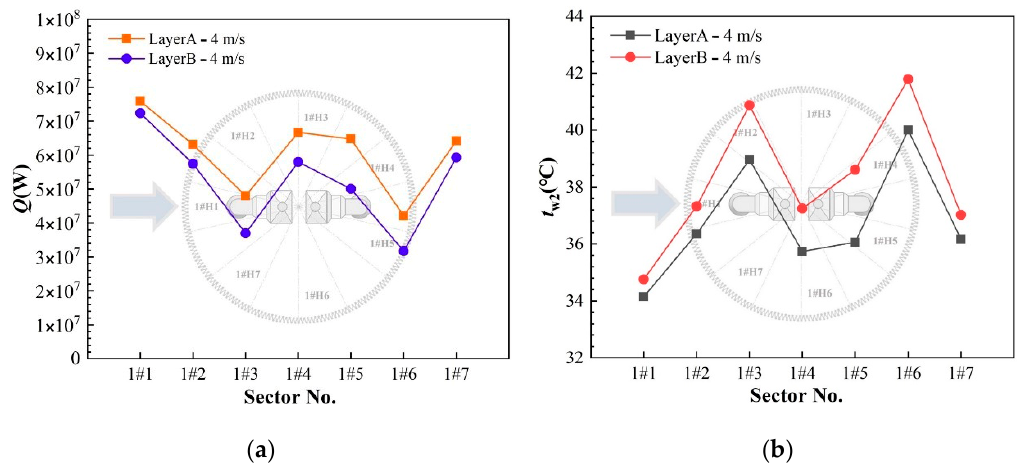
Figure 13. Heat rejections and water outlet temperatures of double-layer sectors under a typical crosswind of 4 m/s in the case of 1 unit. ( a ) Heat rejections; ( b ) water outlet temperatures.